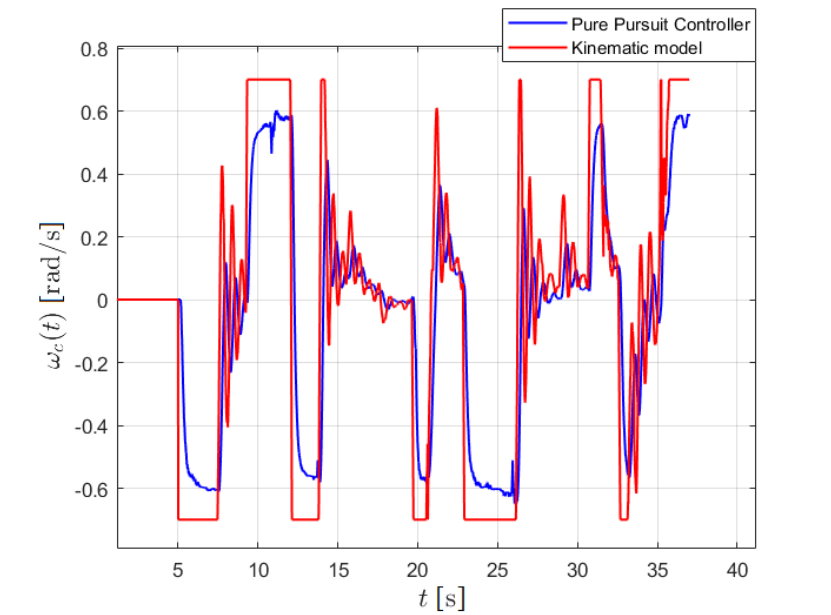
Figure 14. Angular velocity ω c ( t ) of the QBot 2e